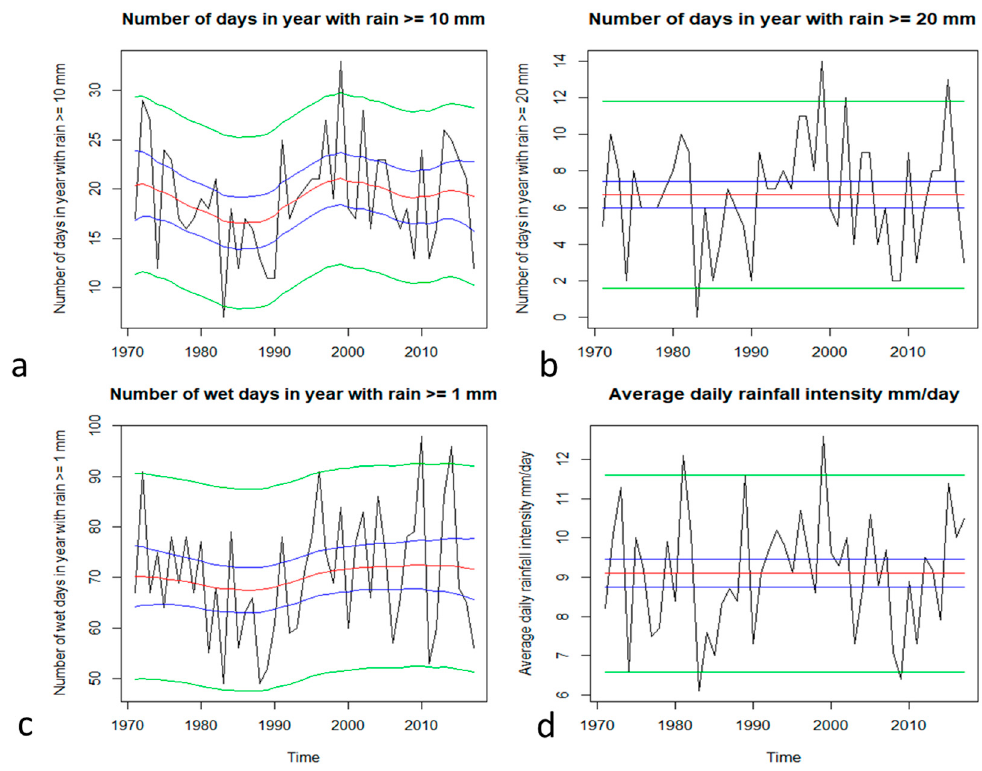
Figure 7. Indexes for extreme climate events concerning precipitation: ( a ) R10 (black line) and its space state model trend (red line) obtained with Kalman filtering; ( b ) R20 (black line) and its space state model trend (red line) obtained with Kalman filtering; ( c ) WD wet days (black line) and its space state model trend (red line) obtained with Kalman filtering; ( d ) Average daily rainfall intensity (mm/day; black line) and its space state model trend (red line) obtained with Kalman filtering. The blue lines indicate the 90% confidence interval and the green lines indicate the 90% prediction interval for the original model object.